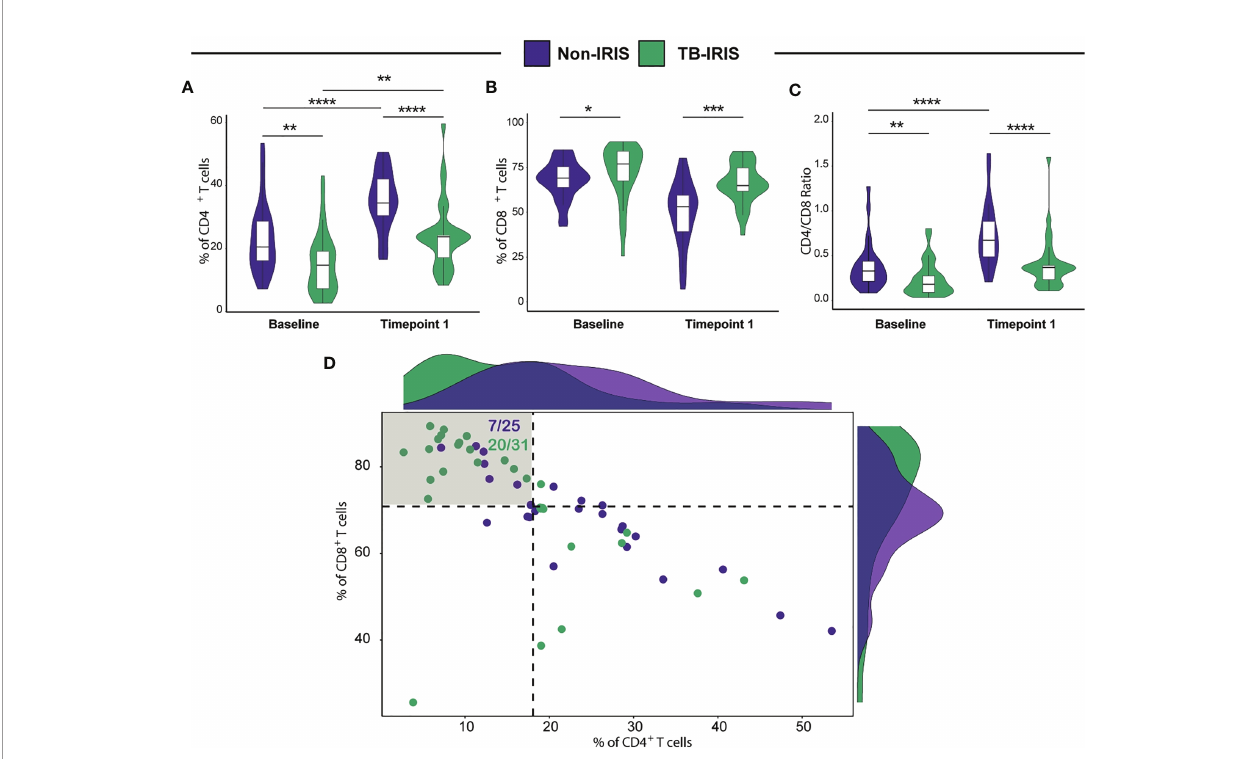
FIGURE 1 | Assessment of both CD4 + and CD8 + T cell frequencies in HIV-infected individuals prior to antiretroviral therapy (ART) initiation and during TB-IRIS manifestations. Comparison of CD4 + (A) and CD8 + (B) T cell frequencies in patients who developed TB-IRIS and those who did not at ART initiation (Baseline) and at the time of TB-IRIS manifestations (Timepoint 1), which occurred between 2 and 6 weeks after ART initiation. (C) CD4/CD8 T cell ratios at the aforementioned conditions. (D) Scatterplot displaying CD4 + and CD8 + T cell frequencies prior to ART initiation. Patients who developed TB-IRIS are depicted by green dots whereas those who did not experience TB-IRIS manifestations are represented by purple dots. Dotted lines on the X and Y axes represent the median value of CD4 + and CD8 + T cell counts within the entire study population, respectively. The shadowed quadrant represents those individuals with CD8 + T cell counts above the median value and CD4 + T cell frequencies below the median value for the entire population. Data were analyzed using the Mann-Whitney test or Wilcoxon matched-pairs test for paired analyses within each study group (*p < 0.05, **p < 0.01, ***p < 0.001, ****p <